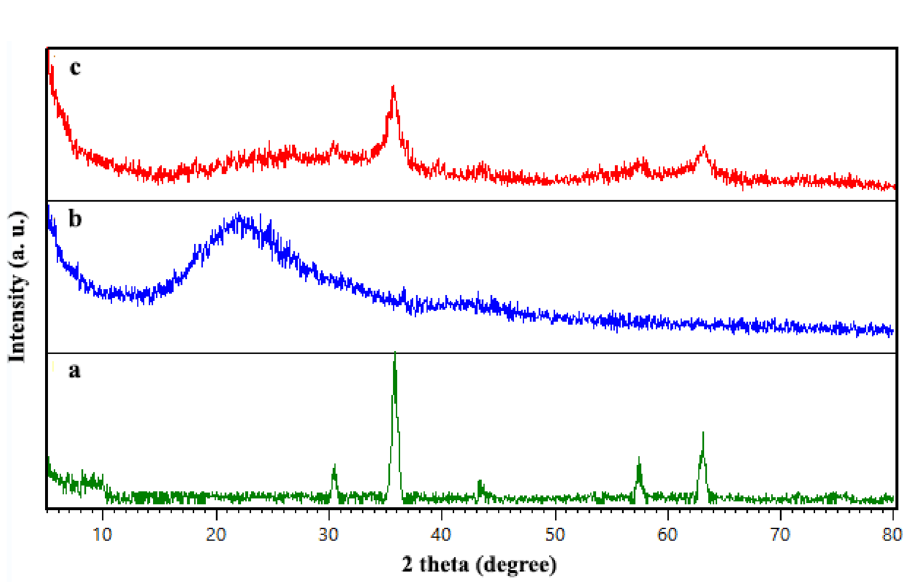
Figure 7. XRD pattern of ( a ) Fe 3 O 4 , ( b ) SBA-15 and ( c ), the guanidinylated SBA-15/Fe 3 O 4